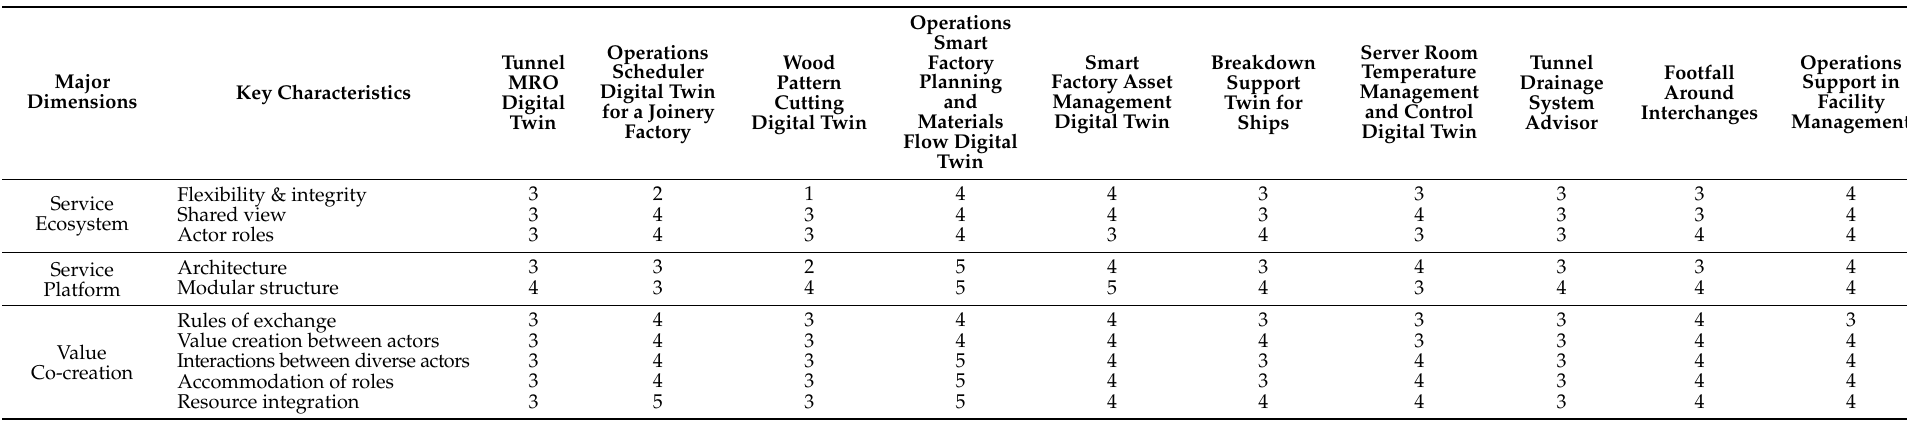
Table 4. Assessment of value co-creation